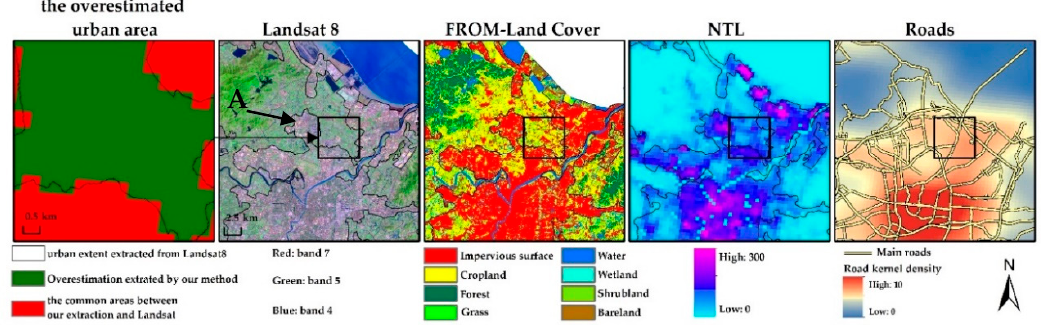
Figure 13. Analysis of overestimation urban area for Ningbo: (black box is the overestimation area zoomed in column 1, which was indicated by “A” in text).